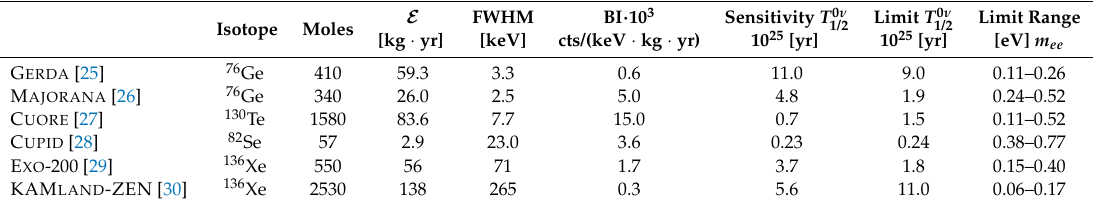
Table 3. Summary and comparison of the main parameters, performance, and results of the ongoing Double Beta Decay Experimental